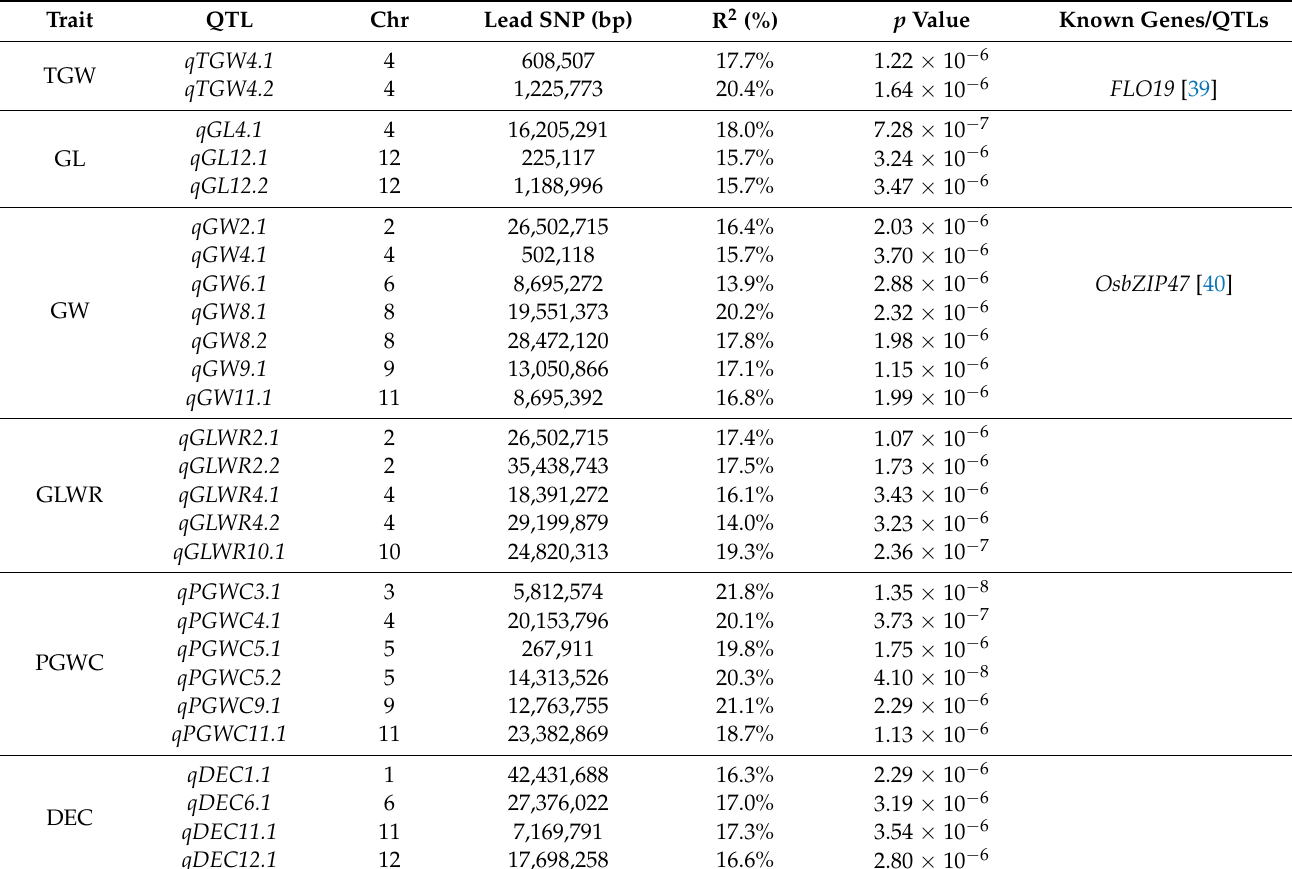
Table 2. Twenty-seven QTLs with significant associations with TGW, GL, GW, GLWR, PGWC and